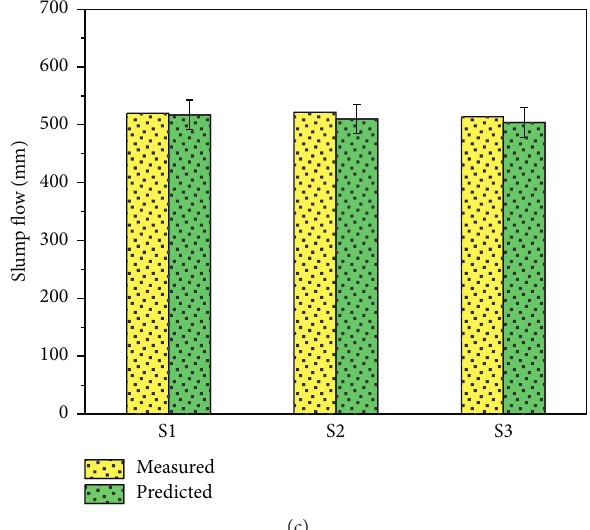
Figure 10: The comparison between the predicted values and the measured values. (a) Segregation rate. (b) Bleeding rate. (c) Slump